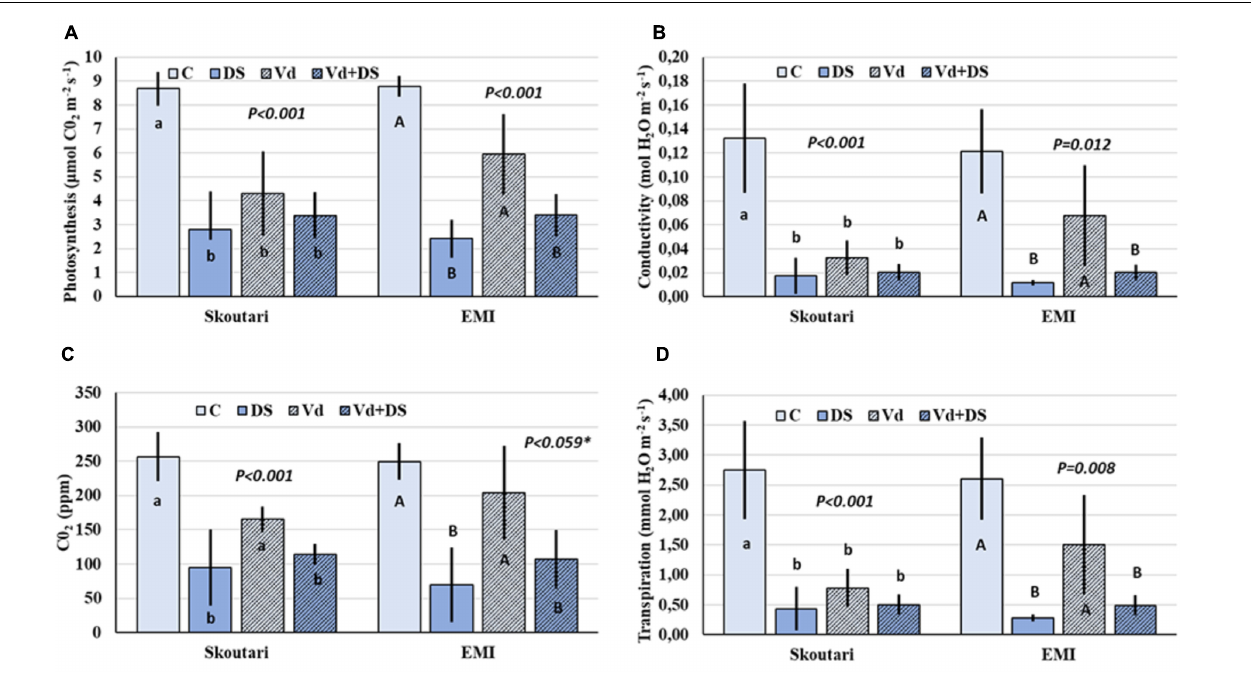
FIGURE 2 | Photosynthesis rate and leaf gas exchange parameters in eggplant cultivars subjected to abiotic, biotic and combined stresses. The net photosynthetic rate ( P N ), stomatal conductance (g s ), intercellular CO 2 concentration ( C i) and transpiration rate ( E ) ( A–D , respectively), were measured in eggplant cultivars under individual and combined stress. C, control; DS, drought stress; Vd, Verticillium dahliae ; Vd+DS, Combined stress. Bars represent standard deviation. Means within the same cultivar with different lower (Skoutari) or upper (EMI)-case letters are significantly different according to Student Newman Keuls test ( P < 0.05 or P < 0.1 ∗